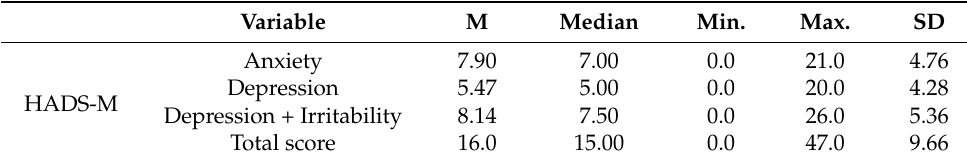
Table 1. HADS-M scores for anxiety, depression, and irritability and scores for the sense of loneliness: descriptive statistics.